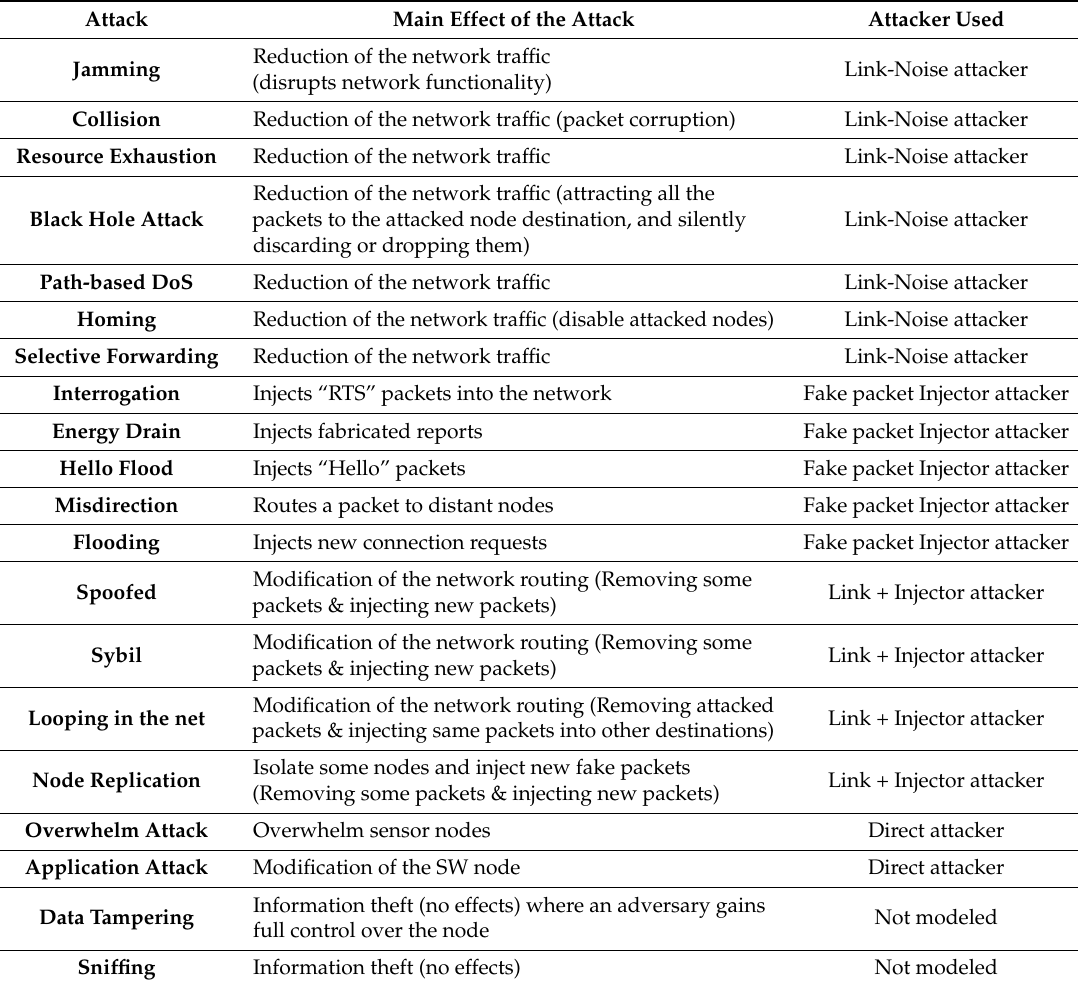
Table 2. Relation between proposed attackers and real WSN